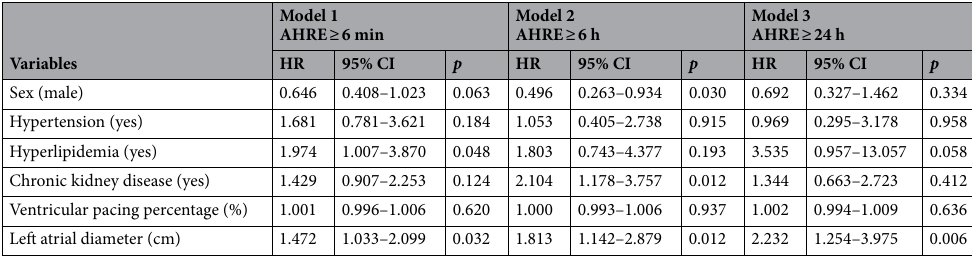
Table 5. Multivariate logistic regression analysis for independent factors of atrial high rate episodes ≥ 6 min, ≥ 6 h, and ≥ 24 h in 470